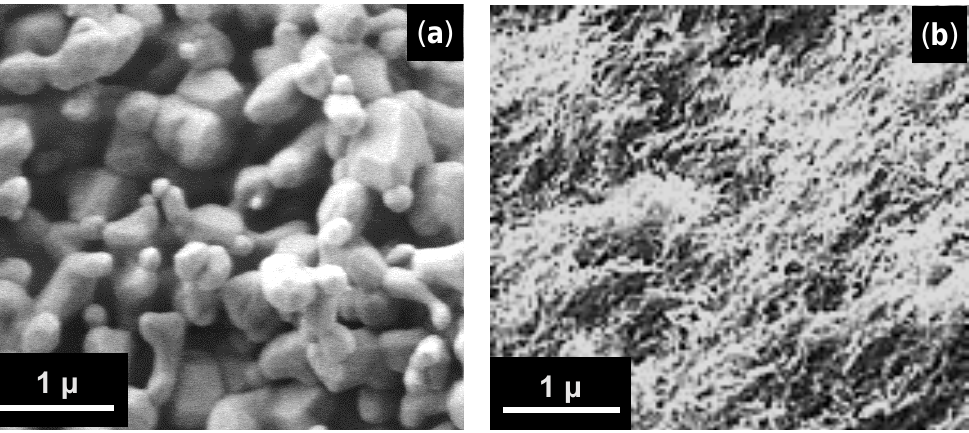
Figure 5. Effect of the annealing in air at the temperature of 1400 °C for 4 h on morphology of the samples: SEM images of ( a ). PMOA, and ( b ). PMOA-M.